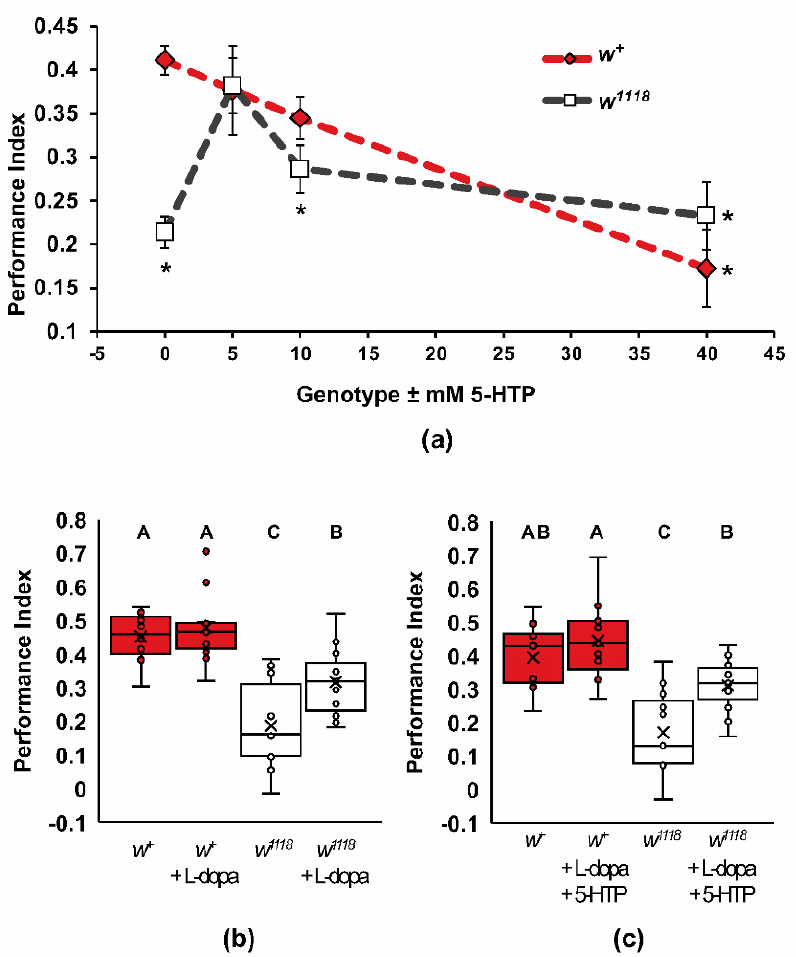
interaction between increasing 5-HT and L-dopa in the w 1118 mutants (Figure 6c). Feeding wildtype flies both 5mM 5-HTP and 2 mg/mL L-dopa did not significantly affect learning (two-way ANOVA, Adj. R 2 = 0.467, F 3,40 = 13.544, p < 0.0001; Tukey post hoc, p < 0.05, n = 11); however, the w 1118 mutants achieved a partial rescue of learning, like that of L-dopa alone ( p < 0.05).